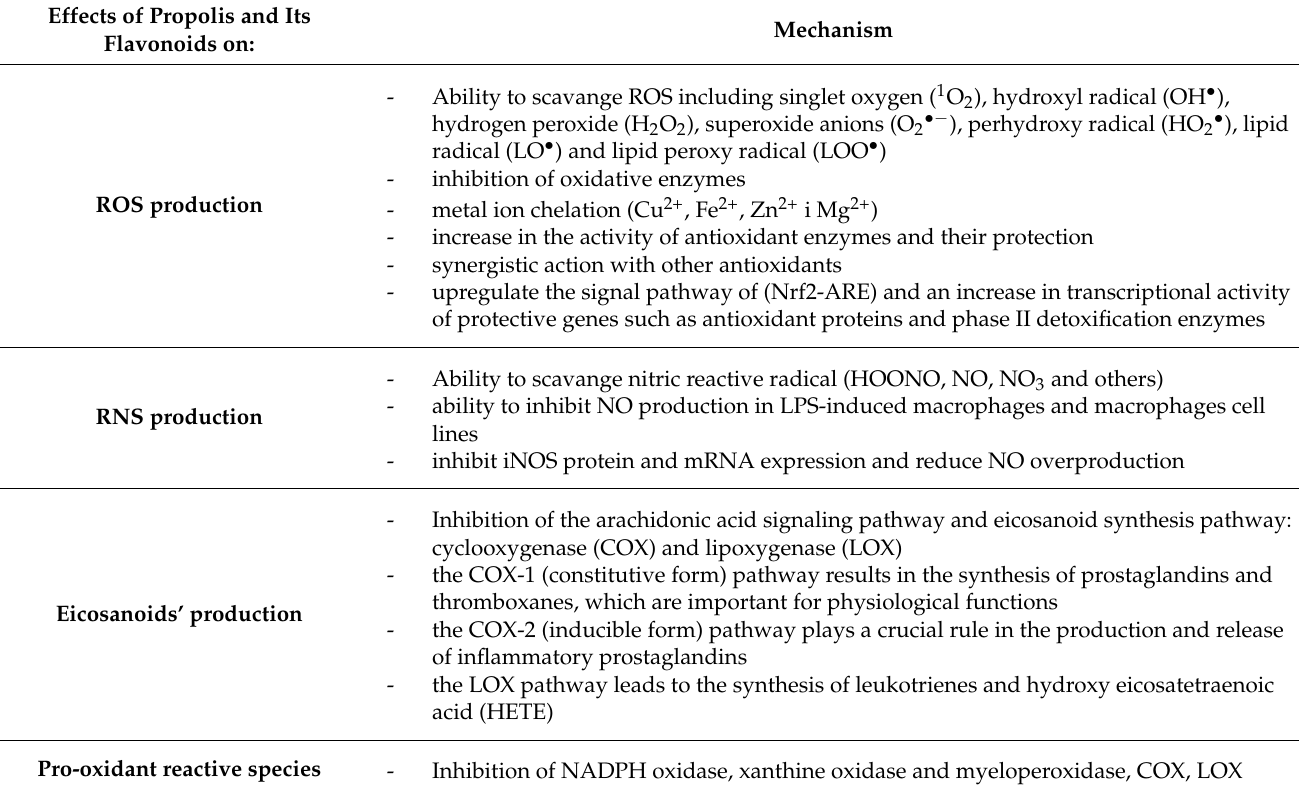
Table 9. Anti-inflammatory and antioxidative properties of propolis and its